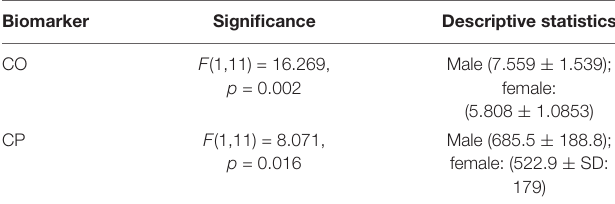
TABLE 2 | Description of the biomarkers that showed a statistically significant main effect of gender when comparing the AG training levels with the standing